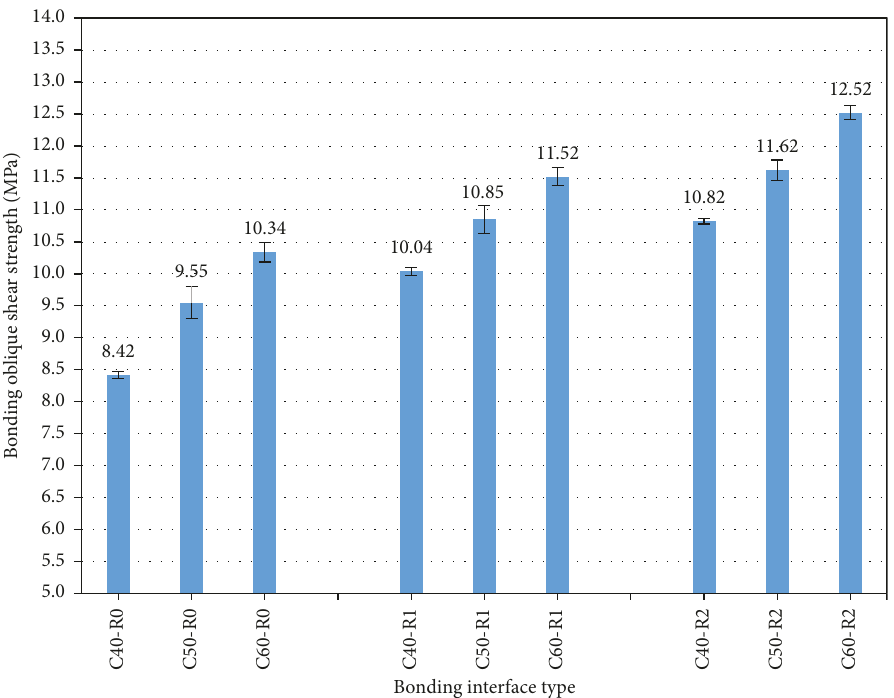
Figure 31: Bond oblique shear strength under different interface roughness and different cement concrete.